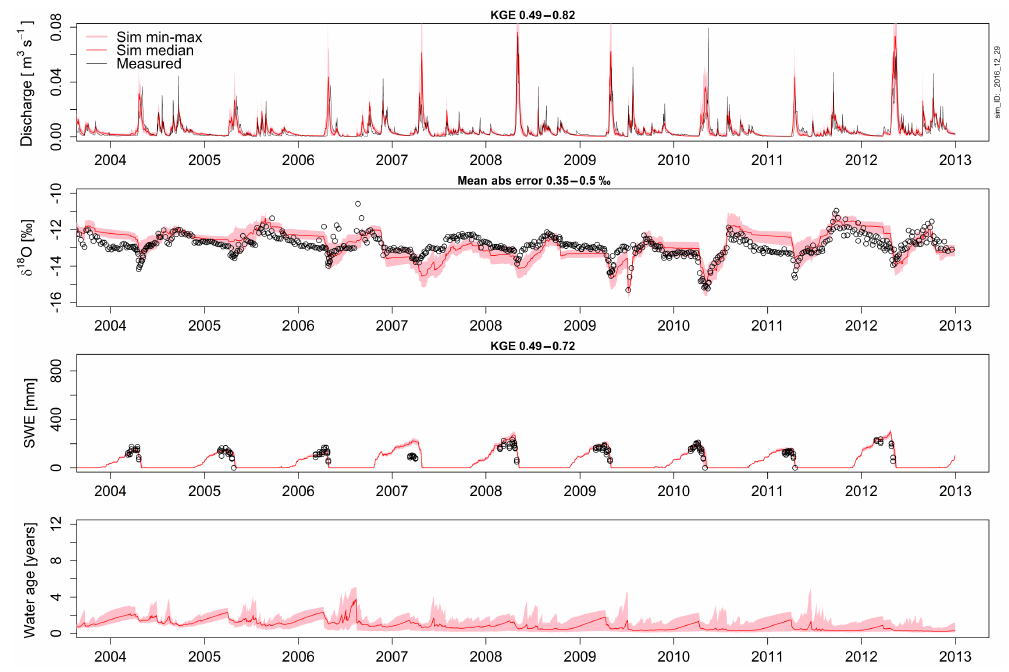
Figure 5. Krycklan C7 simulation output: top panel shows the streamflow, second panel the isotope ratio at the stream outlet, third panel the SWE, and lowest panel the simulated stream water age. GOF measures are shown on plot